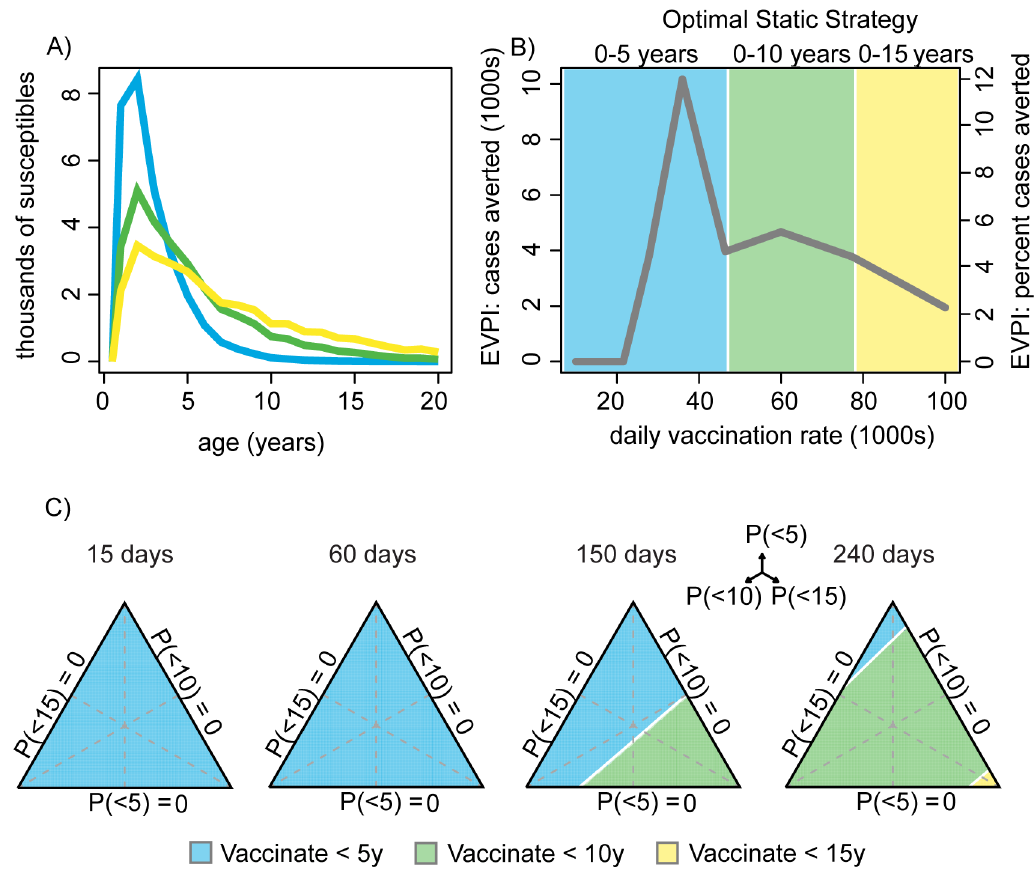
Figure 5. Analysis of the measles vaccination case study. (A) The number of susceptible individuals in each age class for the three alternative age distribution models for measles. (B) The EVPI as a function of the daily vaccination rate, colors indicate the optimal intervention (blue, vaccinate 0–5 years; green, vaccinate 0–10 years; yellow, vaccinate 0–15 years) for each vaccination rate. (C) The optimal vaccination target age, as a function of the weight on each of the three models of the susceptible population (axes on ternary plots) and the time, in days, at which the vaccination target can be changed to the optimal target conditional on the true susceptible age distribution (colors are as in panel B).